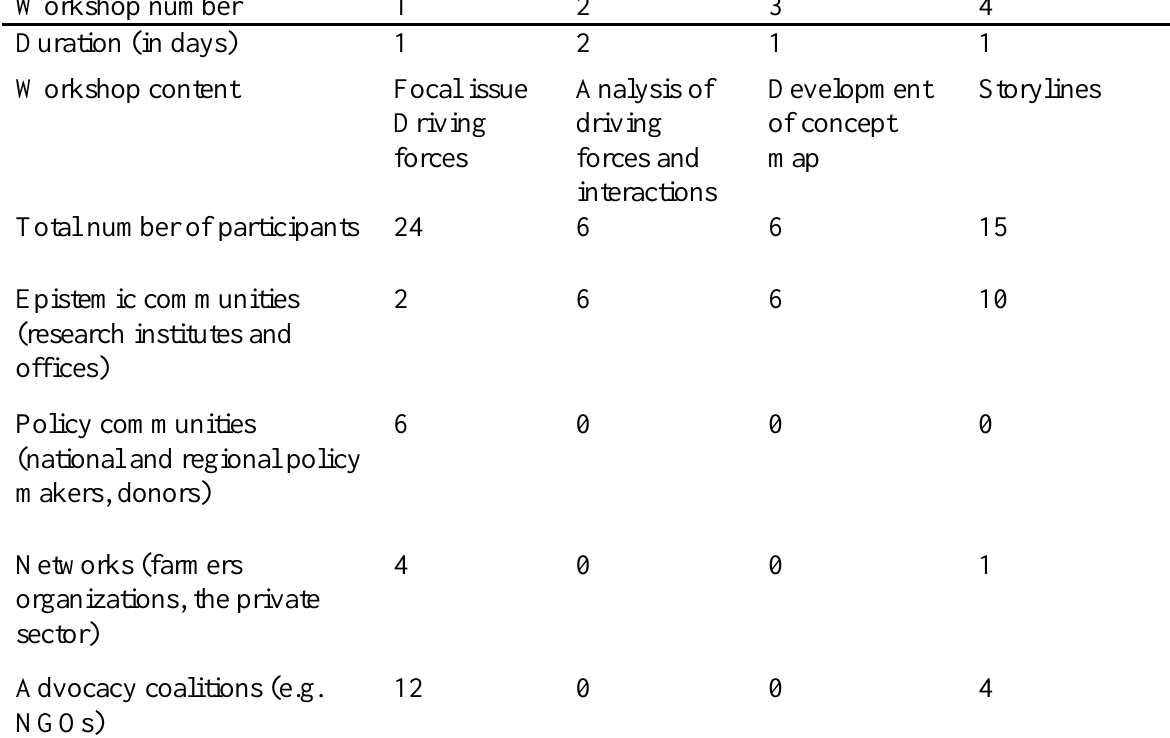
Table A1.3: Overview of the workshops undertaken in the Rwenzori region organised by Mountains of the Moon